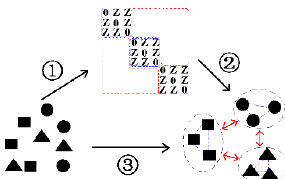
Figure 2. Illustration for block-diagonal constrained low-rank and sparse based embedding (BLSE) model. ① BLSR is applied to get the block-diagonal constrained low-rank and sparse representation of data. ② The representation results of BLSR is utilized to construct the intra-class and inter-class graphs. ③ BLSGE finds a low dimensional embedding with enhanced intra-class compactness and inter-class separation using the graphs.